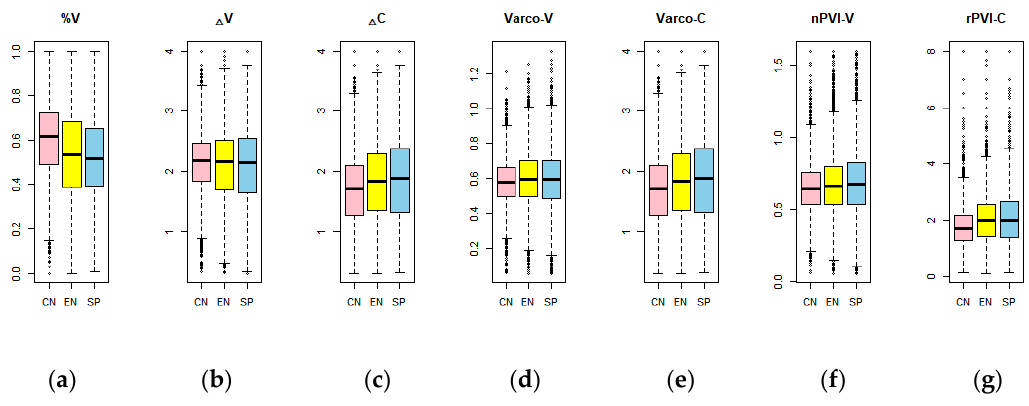
Figure 7. Tendency of distribution of rhythm metric values for Chinese, Spanish, and English.